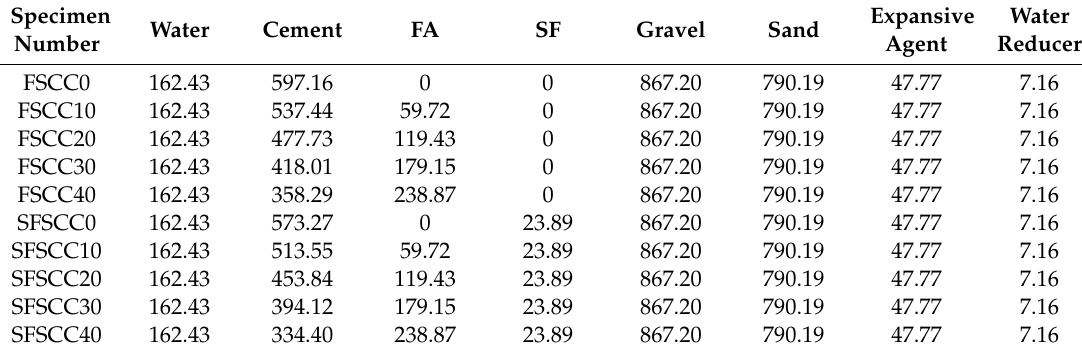
Table 3. Mix Proportion of SCC (kg / m 3